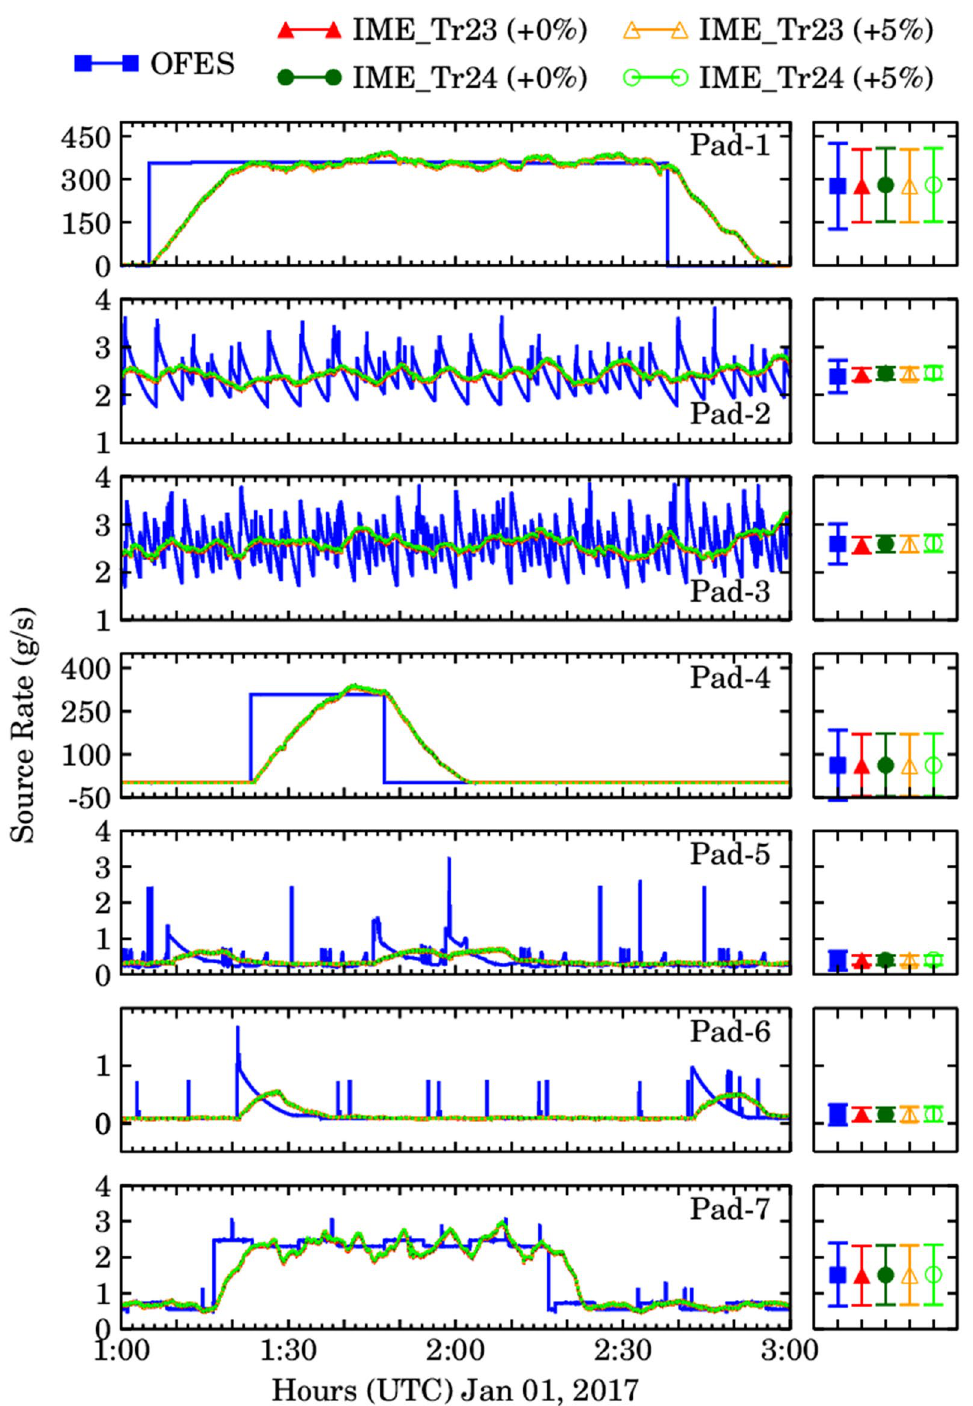
Figure 5. The comparison of OFES source rates (blue), IME derived source rates with no noise scenarios (red) and IME derived source rates with 5% random noise scenario (orange) over seven well pads from top to bottom using 1-s plumes. Different symbols represent source rates determined from different effective wind speed using tracer 23 (IME_TR23, shown as triangles) and tracer-24 (IME_TR24, shown as